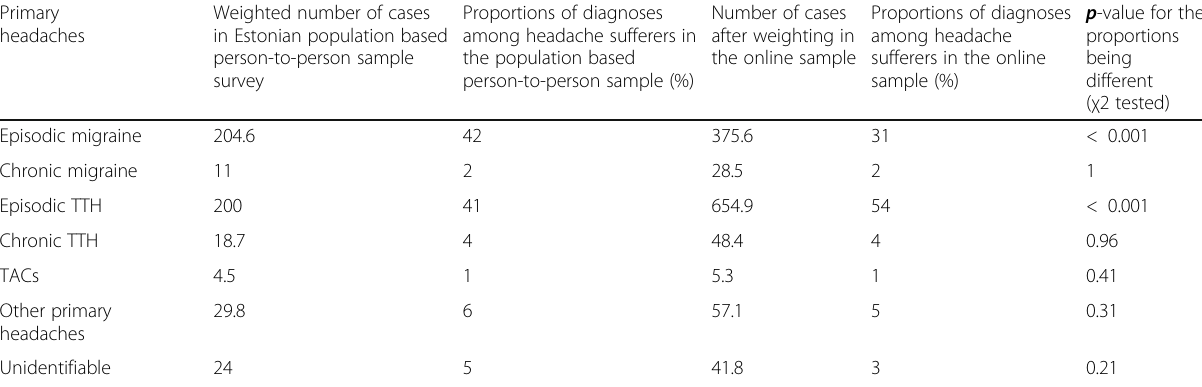
Table 4 Comparison of proportions of different primary headache diagnoses among headache sufferers in the two